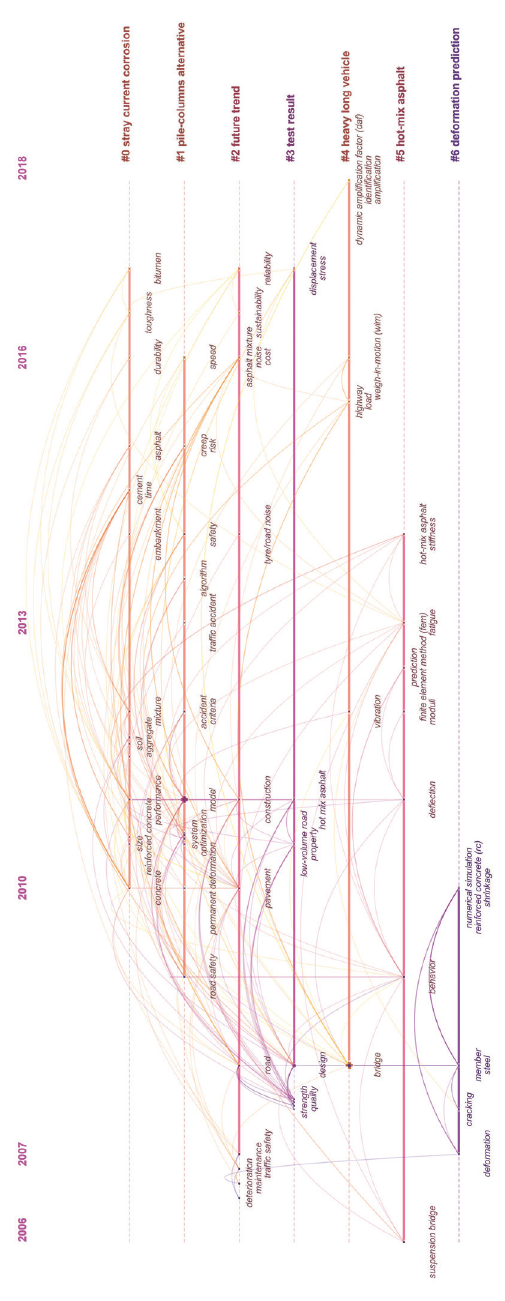
Figure 10. Timeline view for the Baltic Journal of Road and